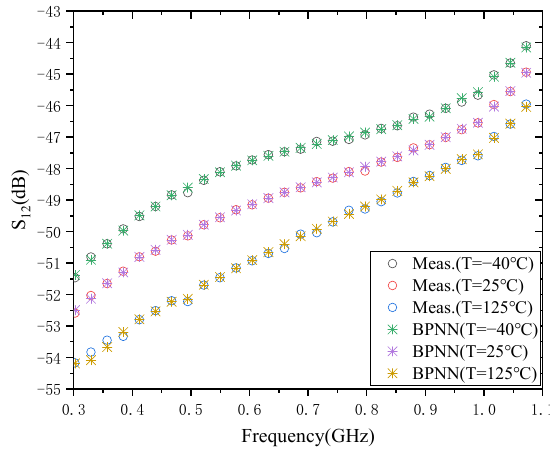
Figure 4. Modeling results of S 12 .